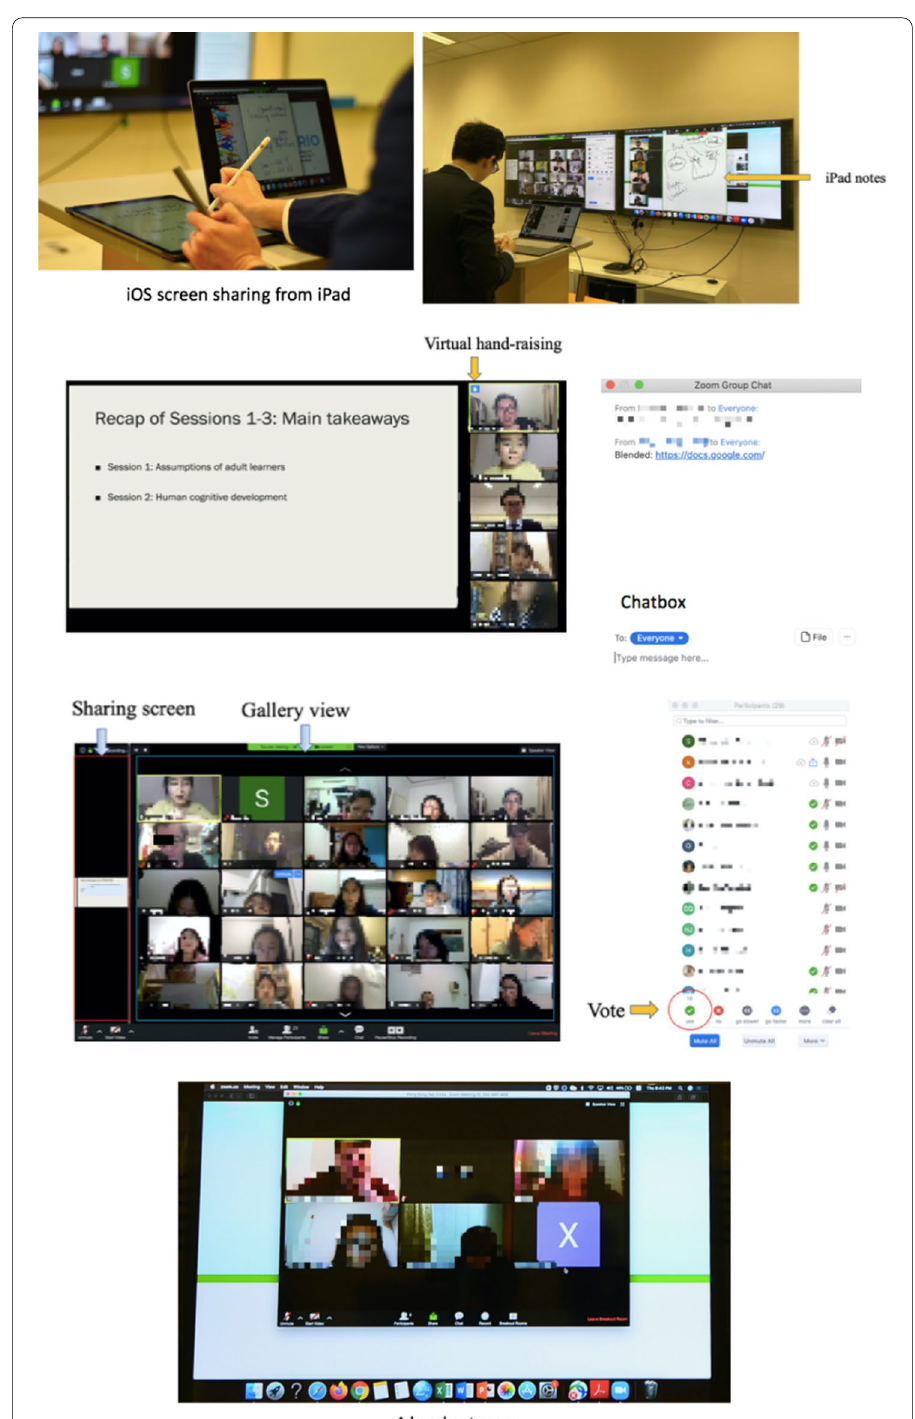
Fig. 7 Examples of Zoom features used in Course